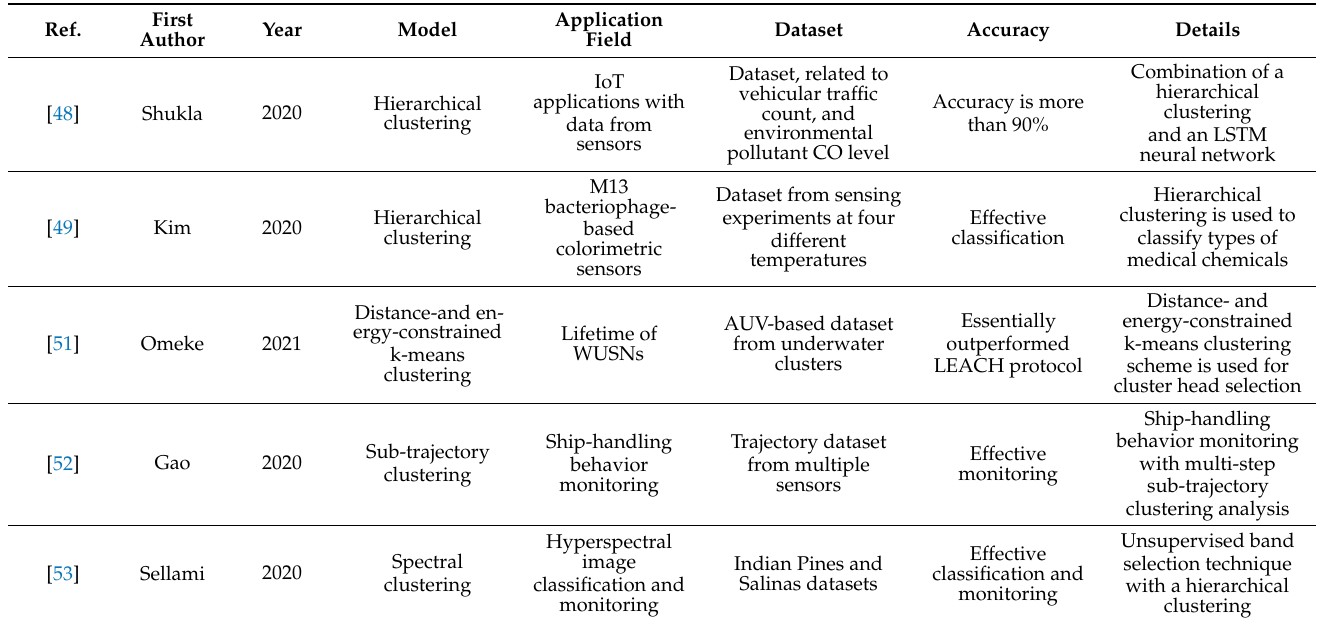
Table 2. Summary of the advances in unsupervised machine learning for sensing and condition